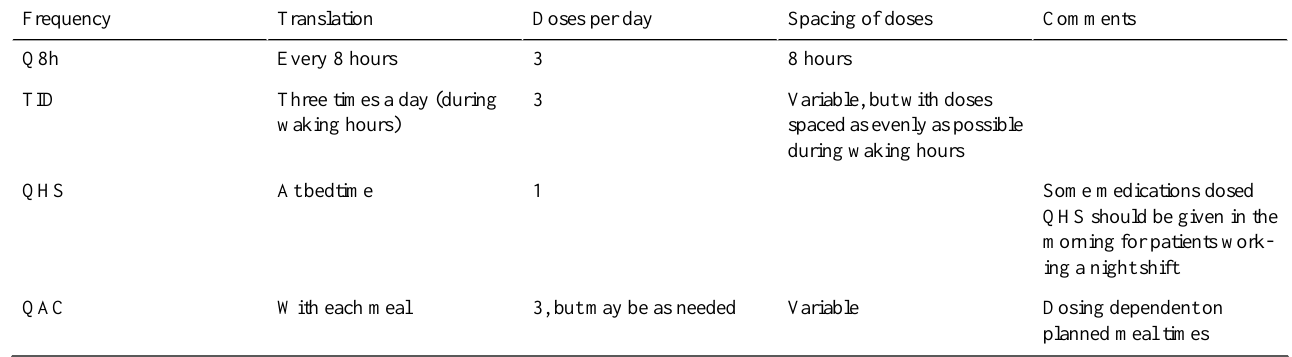
Table 2. Encoded dosing frequencies and metadata